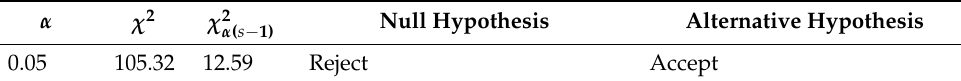
Table 16. The results of the Friedman statistic when the algorithms number s = 7 and standard instances number n = 27.